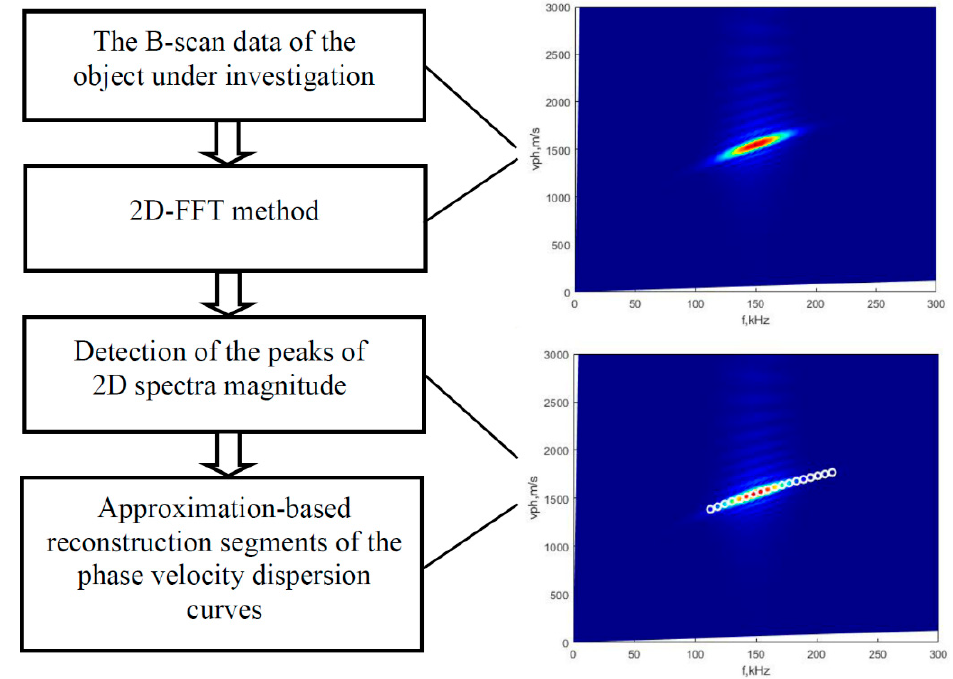
Figure 1. An algorithm of the 2D-FFT method based on peak detection of 2D spectrum magnitude. The algorithm consists of two main stages: the 2D-FFT method application and calculation of peak detection of 2D spectrum magnitude of the acquired